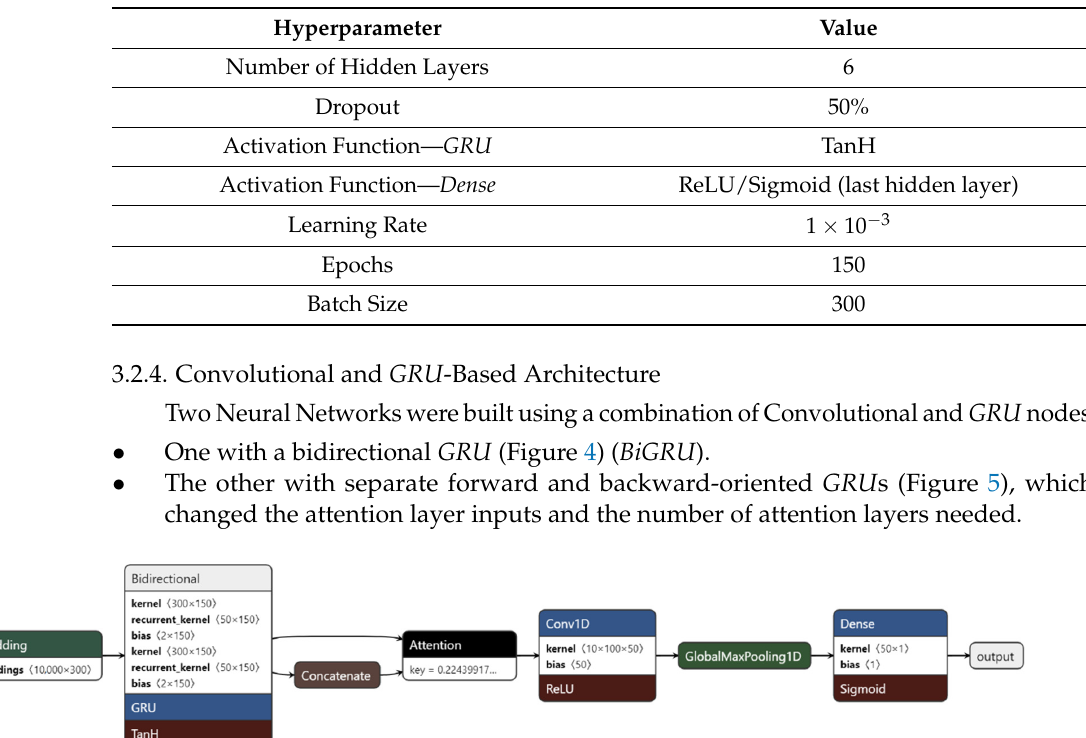
Table 4. GRU hyperparameters.